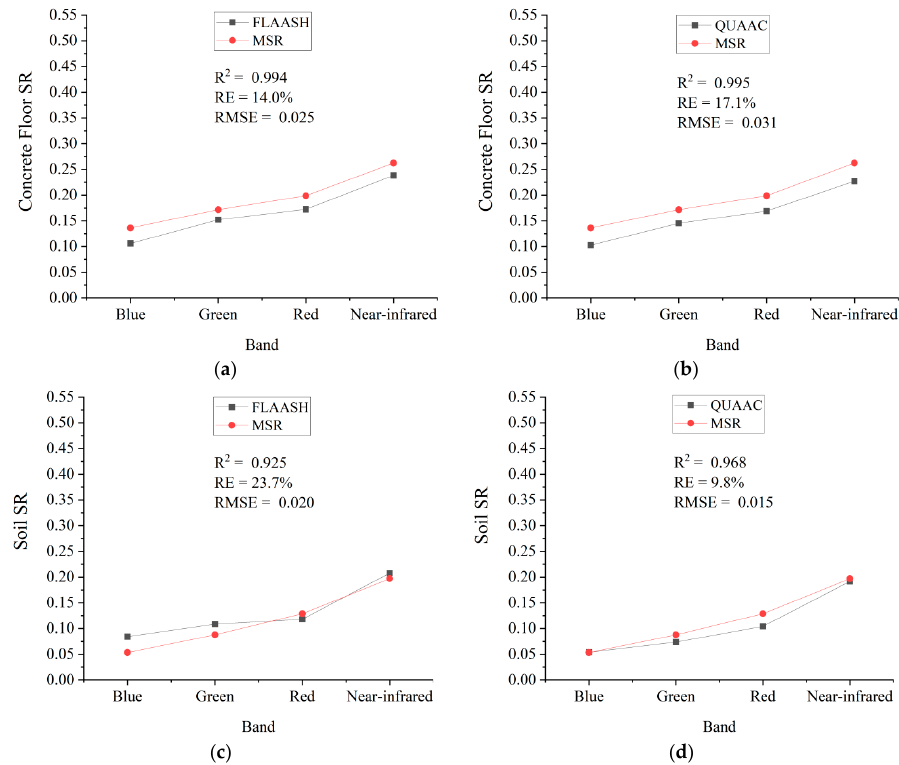
The synchronized MSR is used as the reference data. Multispectral images on the same date and location after FLAASH and QUAAC correction are selected. We compare the FLAASH/QUAAC − corrected SR of concrete fl oor, soil, grassland, gravel, shrub, and water with the synchronized MSR respectively. The R (cid:2870) , RE, and RMSE are used to evalu- ate the accuracy. The comparison charts are shown in Figure 5.